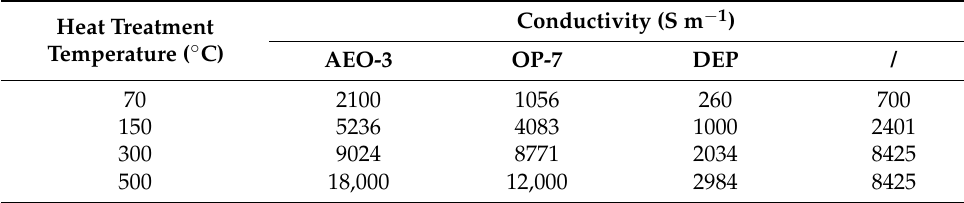
Table 6. The conductivity of RGO with different temperature heat treatments.